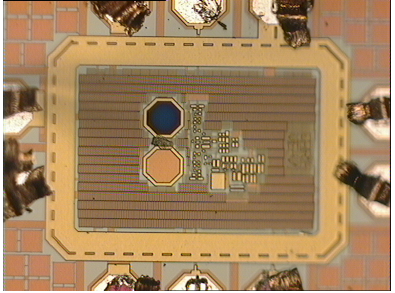
Figure 3. Micro-photograph of the fabricated